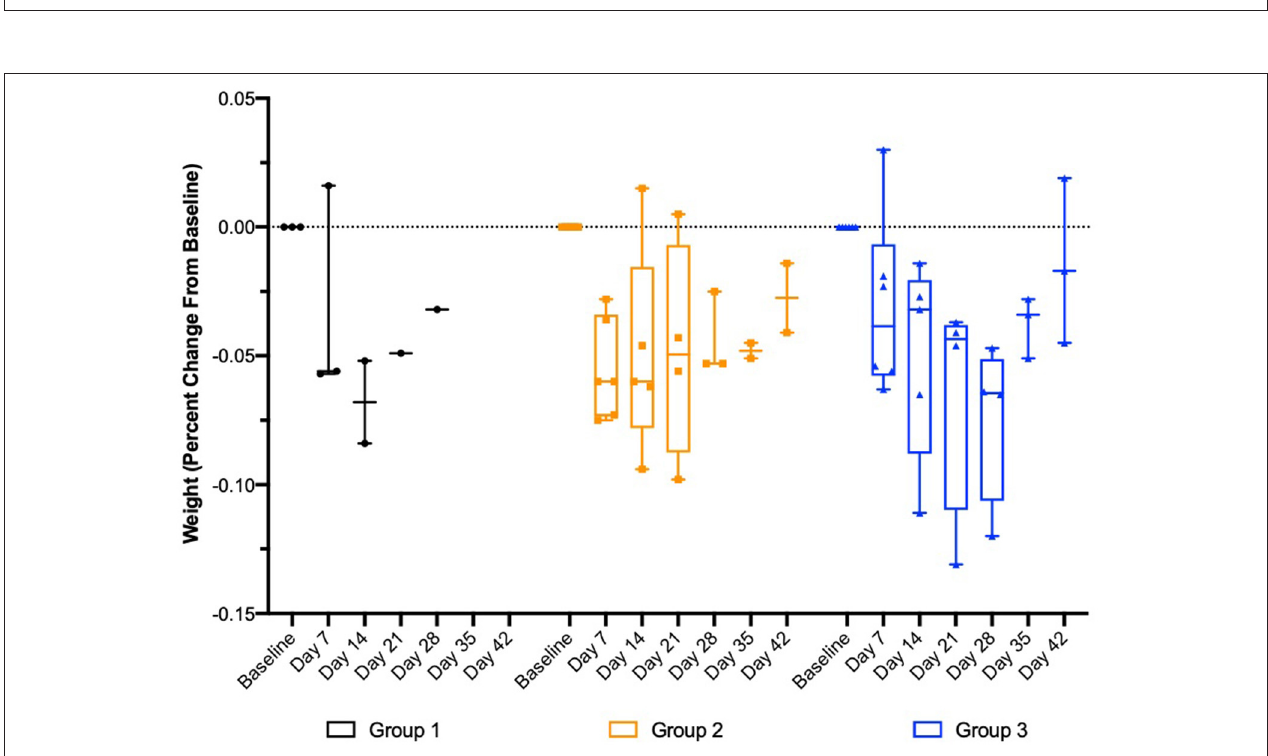
FIGURE 6 | Change in body weight in healthy purpose-bred cats randomized to Group 1 ( n = 3, largest NanoPortal configuration, fast release), Group 2 ( n = 6, medium configuration), and Group 3 ( n = 6, thickest NanoPortal configuration, slow release). The horizontal line in each box represents the median, the lower and upper boundaries of the boxes the interquartile range, and the ends of the bars the minimum and maximum values.